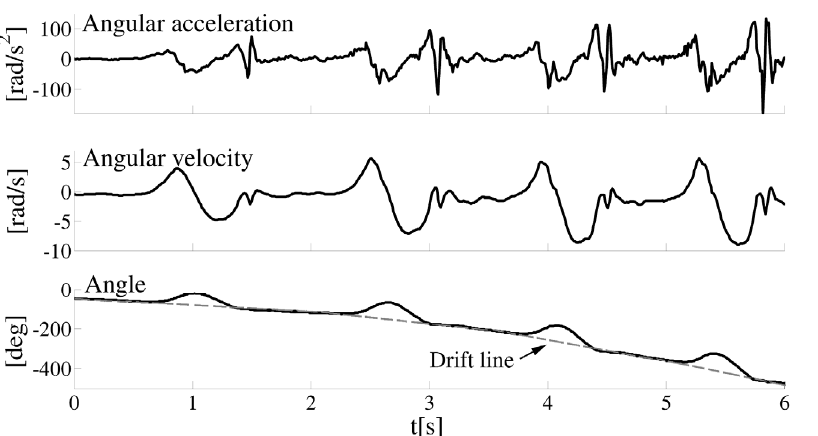
Figure 3. Joint angle (bottom panel) and angular velocity (middle panel) obtained by numerical integration of the measured acceleration of the segment (top panel). Dashed line envelope on the bottom panel is fitted through the points where the knee should be fully extended with zero degree joint angle. However, due to the integration drift, instead of remaining approximately constant, this line has a parabolic